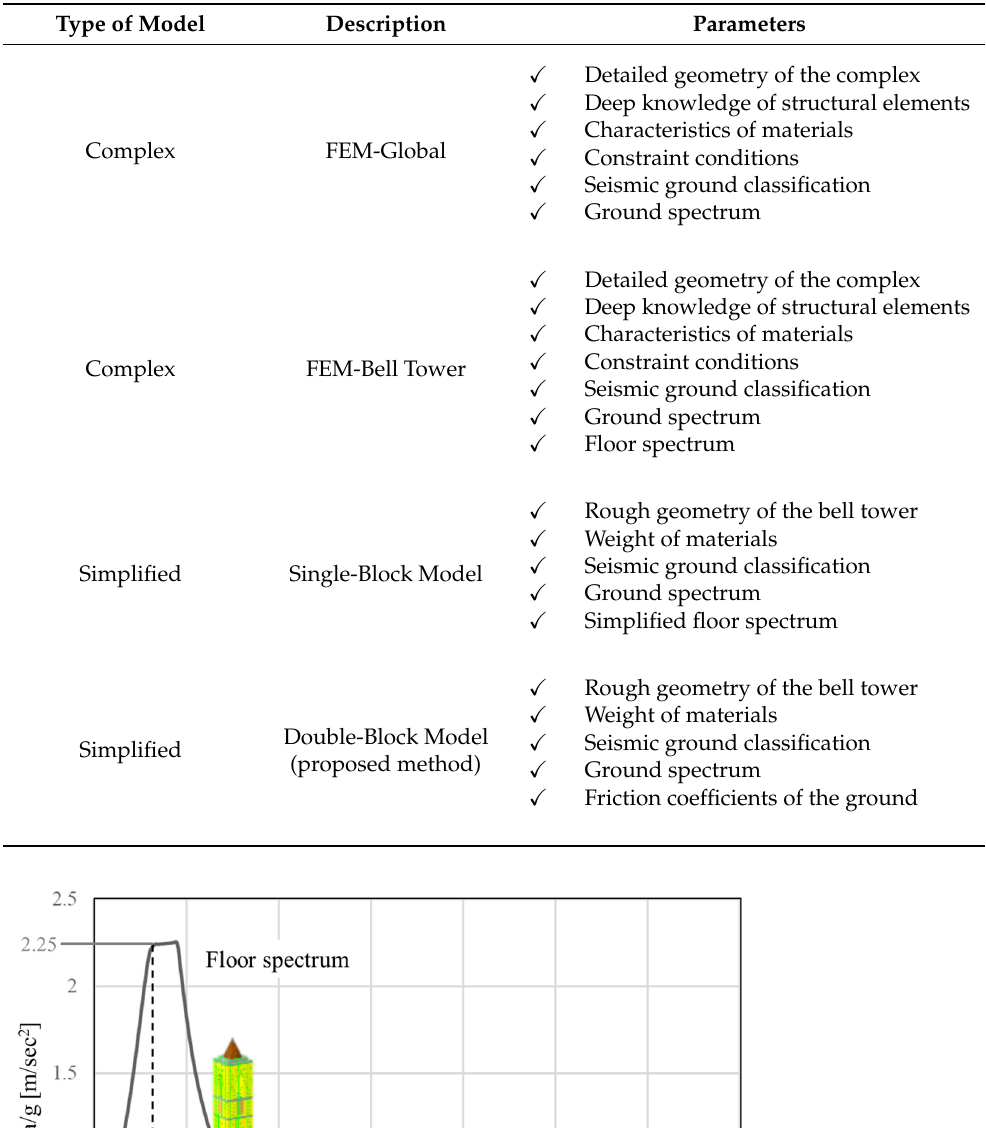
Table 1. Types of model and related parameters.